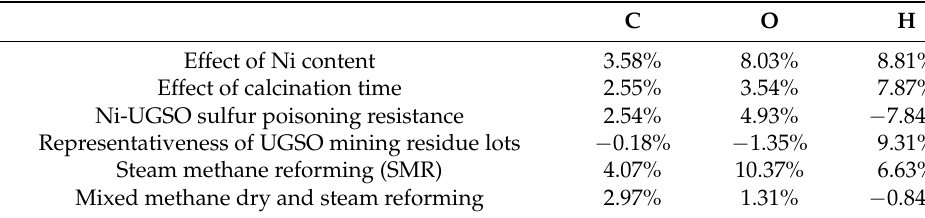
Table 7. Average errors on atomic carbon, hydrogen and oxygen for of each